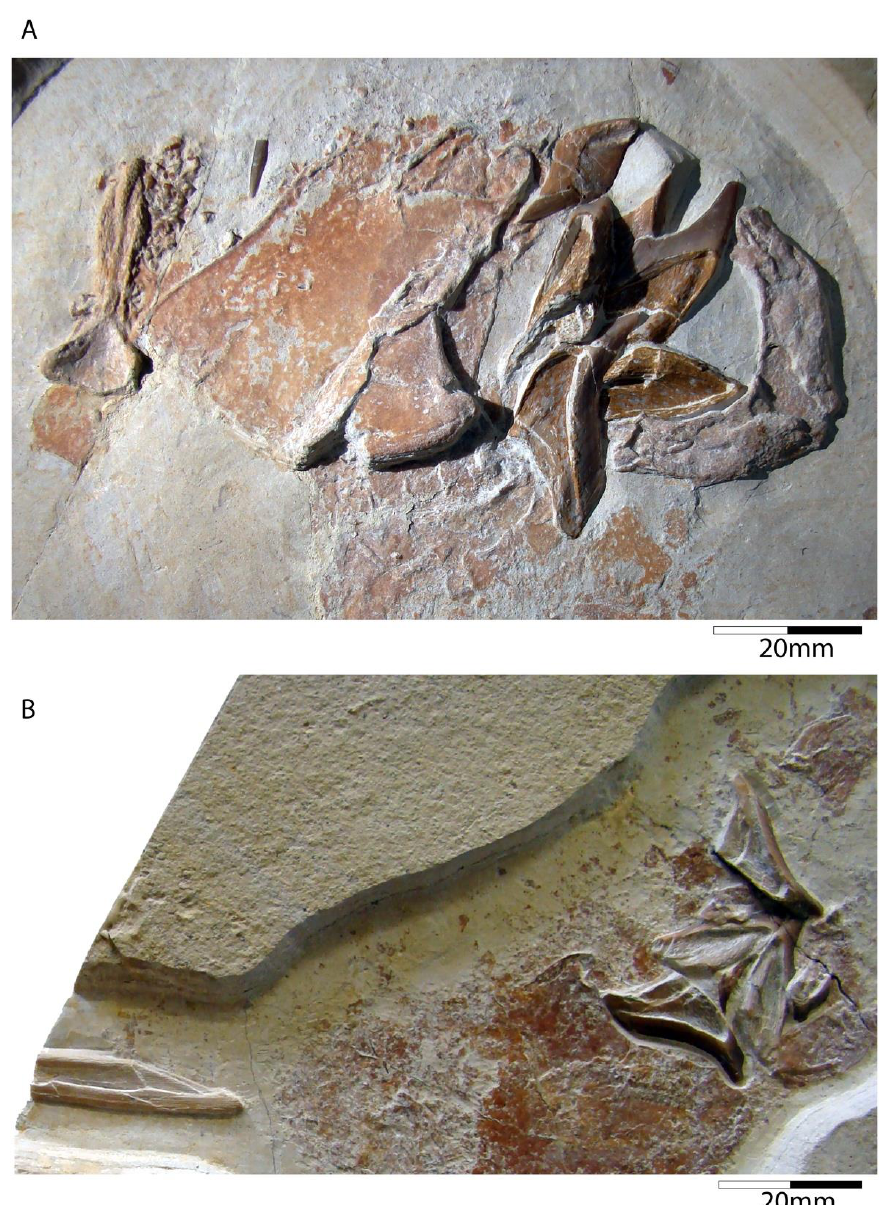
Figure 6. Callorhynchidae indet. ( A ) Cranial remains and basis of fin spine (SMNS 80144/22) from the late Kimmeridgian Nusplingen Plattenkalk of the quarry of the Gesellschaft für Naturkunde Württemberg, labelled as † I. schuebleri . ( B ) Cranial remains including the frontal clasper and complete dentition (SMNS 95823/4) from the late Kimmeridgian Nusplingen Plattenkalk of the quarry of the Gesellschaft für Naturkunde Württemberg, labelled as † Elasmodectes avitus . It was collected in 2011 and figured by Schweigert et al. [118] (pl. 4).